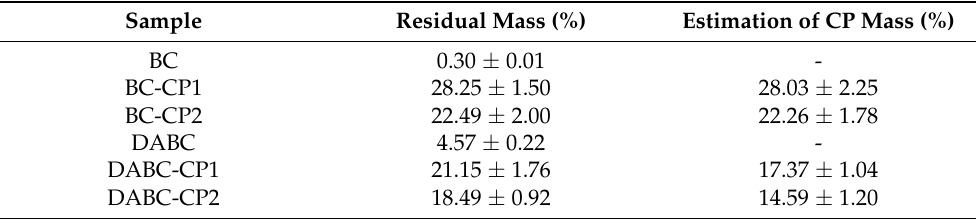
Figure 7. Thermogravimetric analysis (TG and DSC) of the studied samples: ( a ) BC, BC-CP1, and Figure 7 . Thermogravimetric analysis (TG and DSC) of the studied samples: ( a ) BC, BC ‐ CP1, and BC-CP2 and ( b ) DABC, DABC-CP1, and DABC-CP2. BC ‐ CP2) and ( b ) DABC, DABC ‐ CP1, and DABC ‐ CP2. Table 2. Centralized data from thermogravimetric curves of the studied samples.